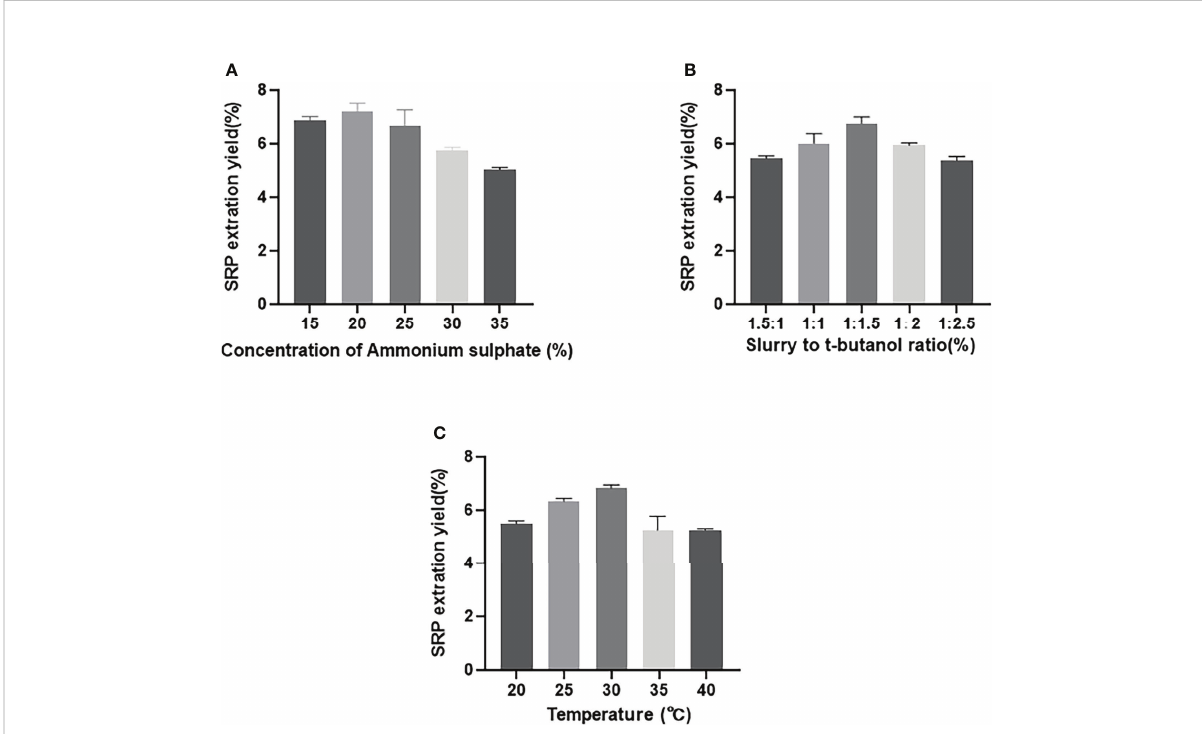
FIGURE 1 Effect of different factors on SRP yield. (A) Concentration of ammonium sulphate; (B) Slurry to t-butanol ratio; (C)